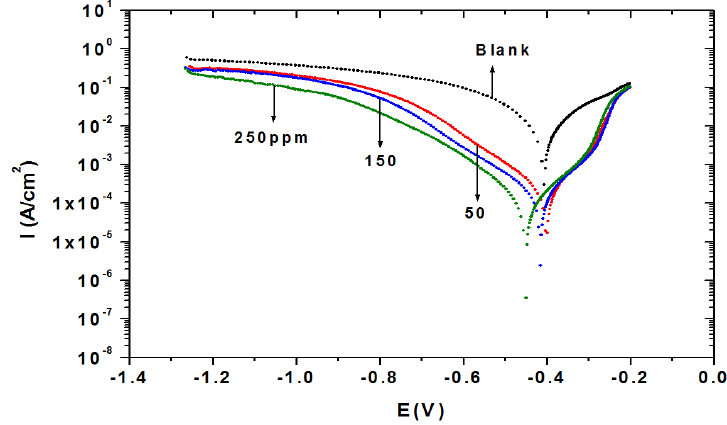
Figure 6. Potentiodynamic polarisation curves for steel in 1.0 M HCl without and with different concentrations of inhibitor.